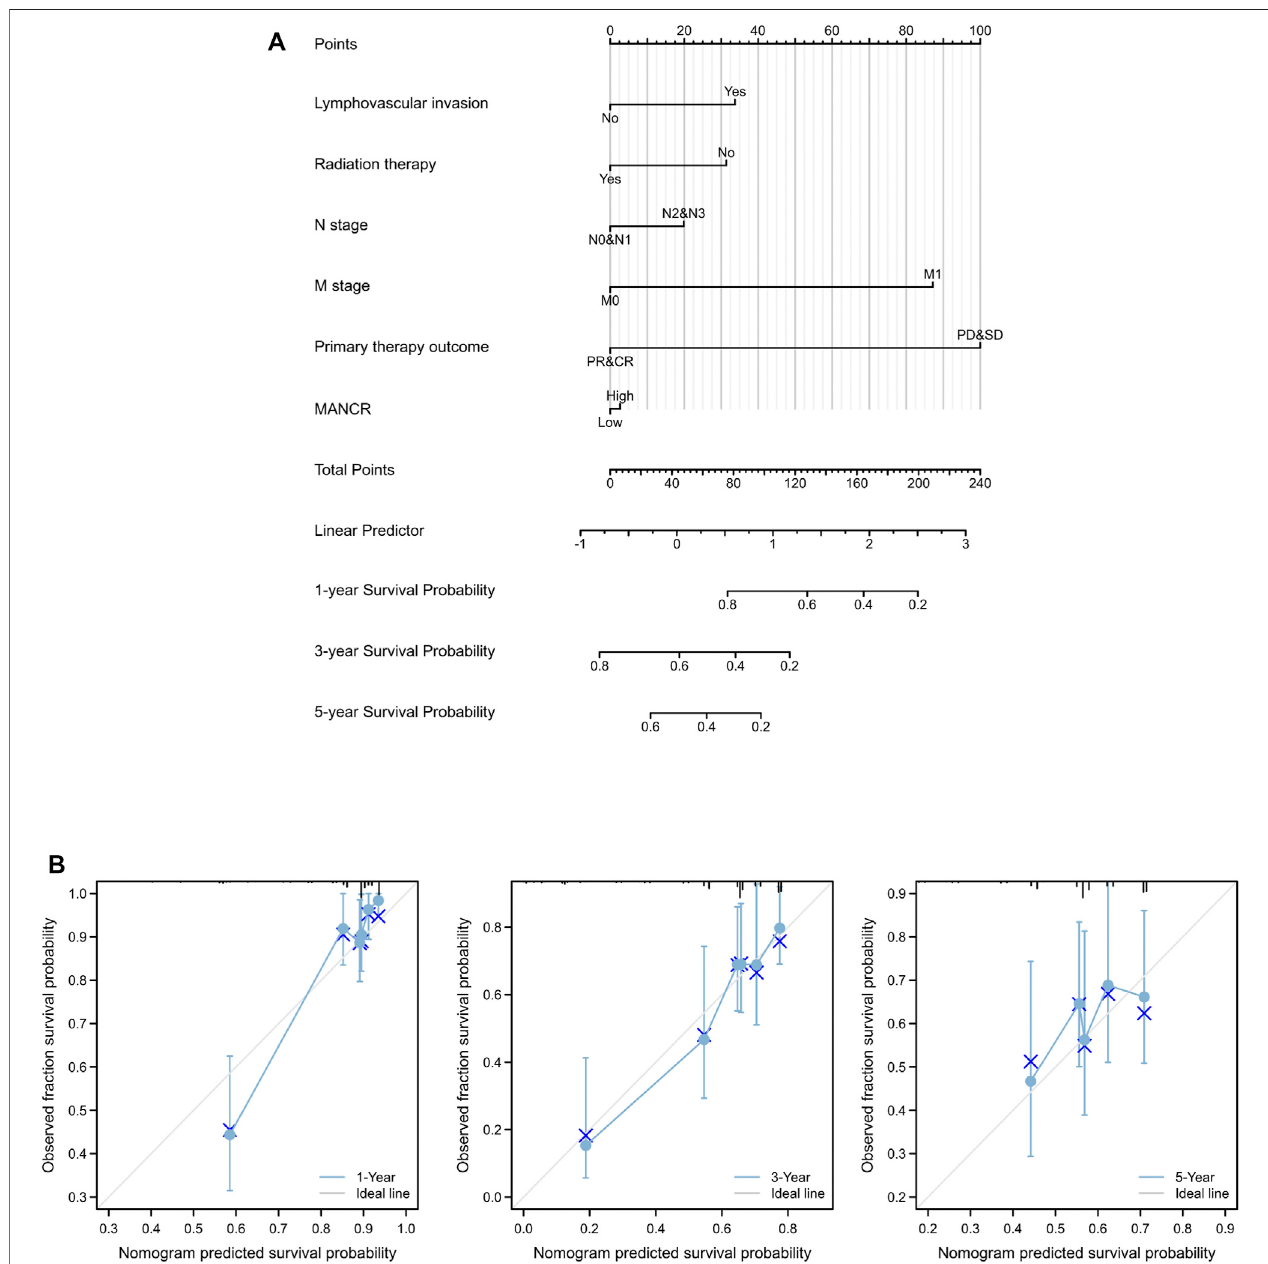
FIGURE 4 | Role of MANCR in predicting the prognosis of HNSCC patients. (A) Nomogram. (B) Calibration curve at different time points.